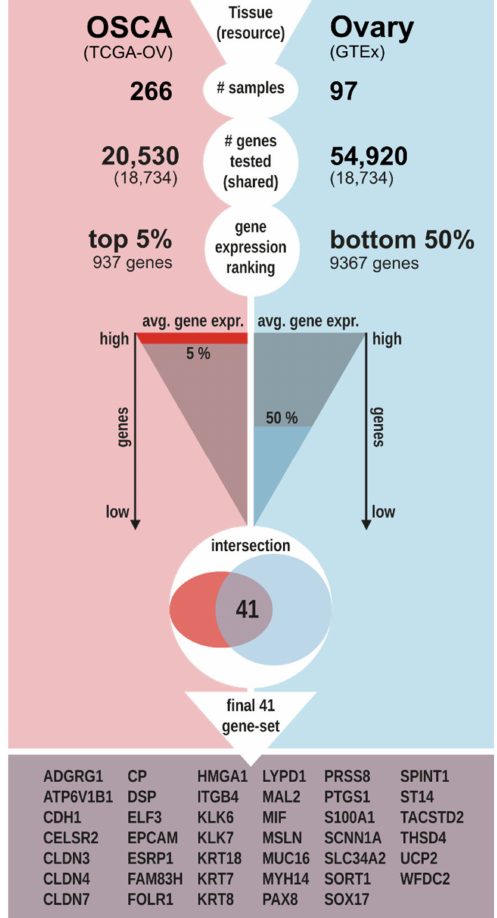
Figure 1. Biomarker identification pipeline. The workflow was applied to identify the 41 putative OSCA gene expression biomarkers in OSCA tissues compared to healthy ovarian tissues by gene expression ranking analysis of RNA-seq transcriptomes recovered from TCGA and